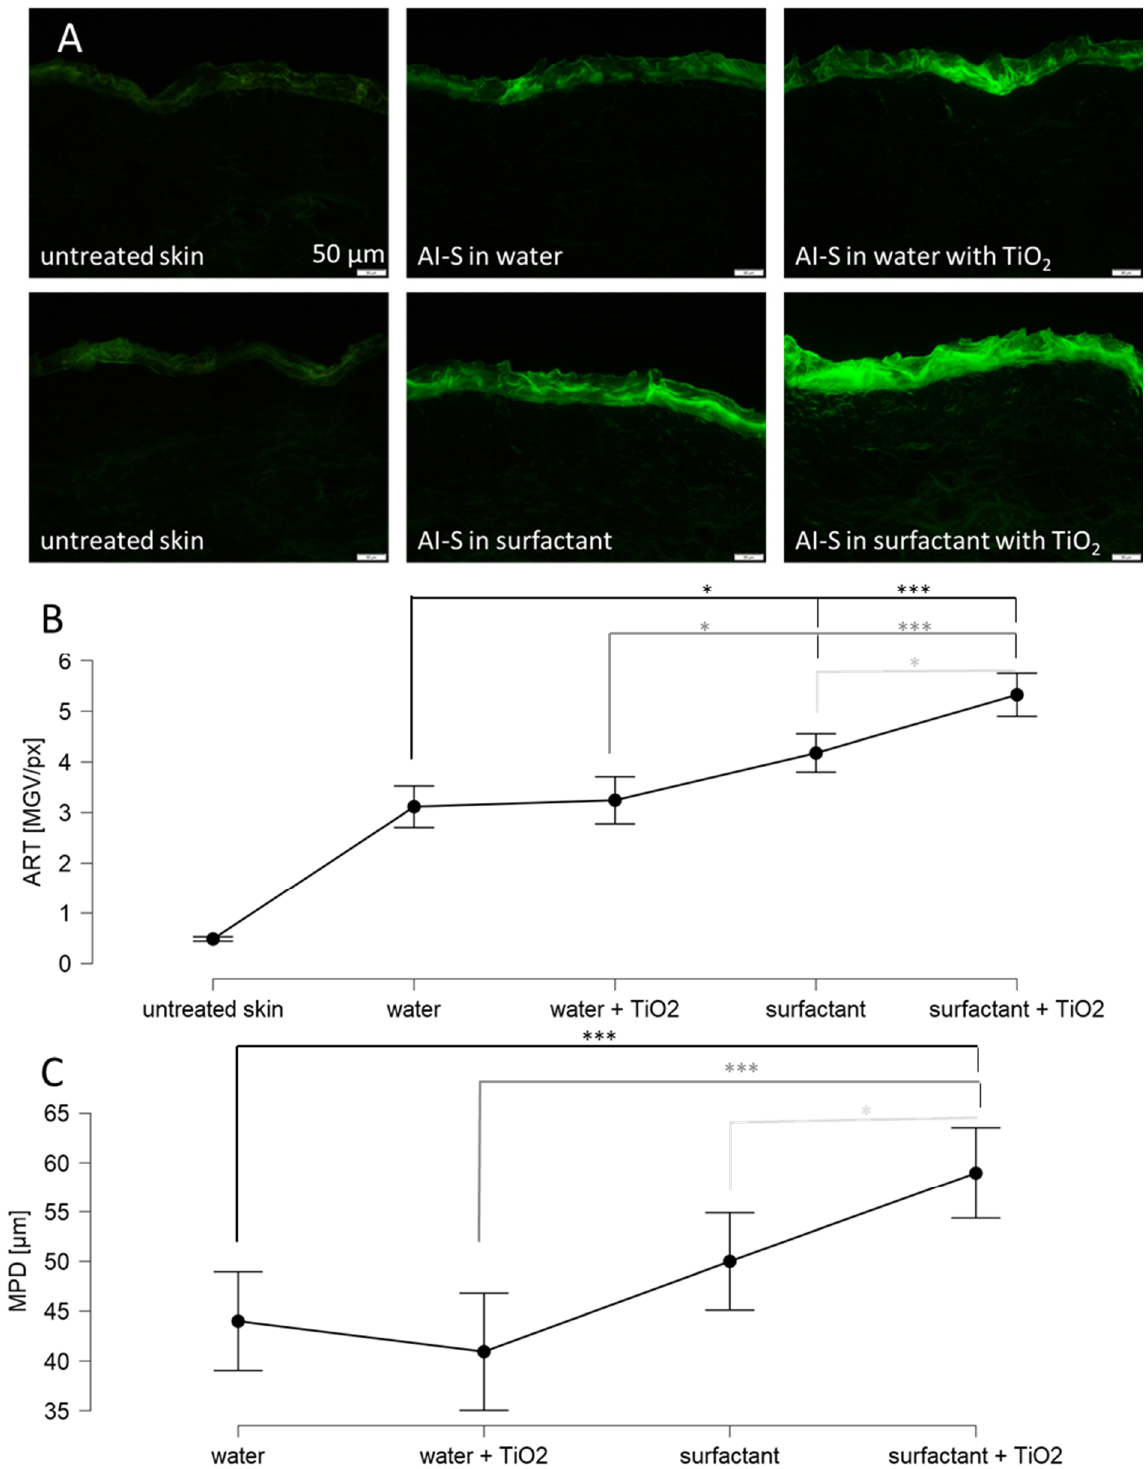
Figure 4. Dermal penetration efficacy of skin treated with sodium fluorescein solution (in water or surfactant) with and without TiO 2 particles. ( A ) images of vertical skin sections obtained by inverted epifluorescence microscopy, ( B ) ART values as surrogate for the total amount of penetrated AI, ( C ) mean penetration depth (MPD). AI-S = AI surrogate = fluorescein. Untreated was significant in relation to all measured values. The asterisks indicate the following p -values: * ≤ 0.05; *** ≤